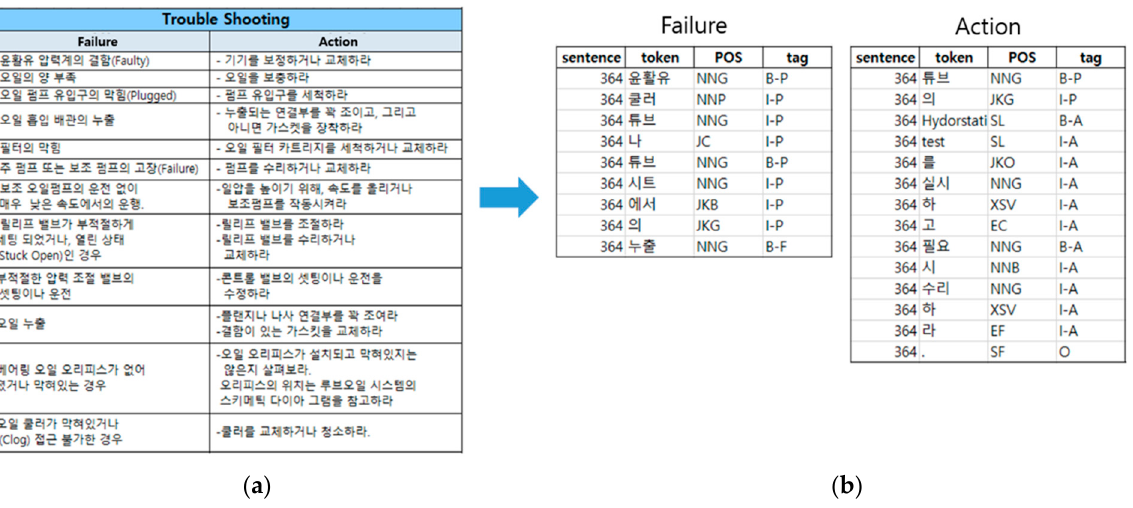
Figure 2. Entity name tagging example: ( a ) original equipment maintenance document example in Korean; ( b ) input examples for the NER model.